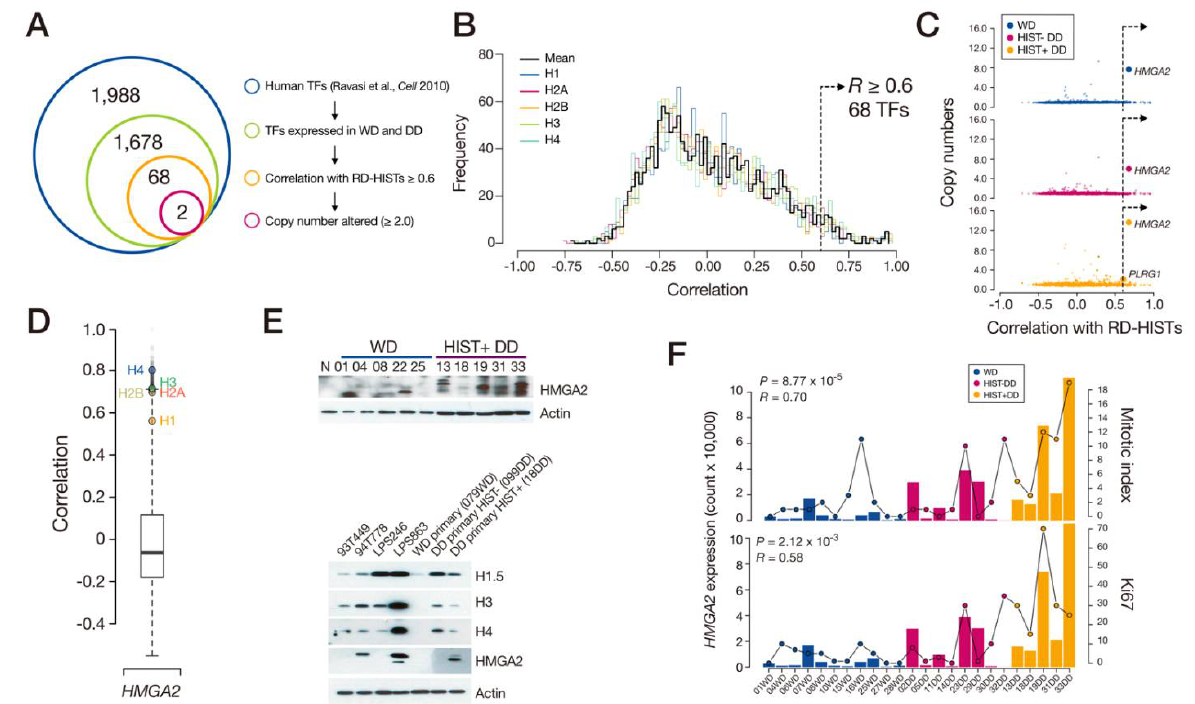
Figure 3. HMGA2 lay upstream of RD-HIST. ( A ) Identification of TFs showing a strong correlation with RD-HIST and DD-specific somatic amplification, leading to two candidates. ( B ) Correlation distribution of TFs against histone subtypes. ( C ) DD-specific somatic amplification involving the two candidate TFs, namely, HMGA2 and PLRG1 . ( D ) Correlation of HMGA2 against whole genes, displaying histone genes at the top. ( E ) Western blot of HMGA2 and selected histones from tumor samples (up) and various cell lines (bottom). ( F ) Correlation between HMGA2 expression and cell proliferation indices of the tumor samples.